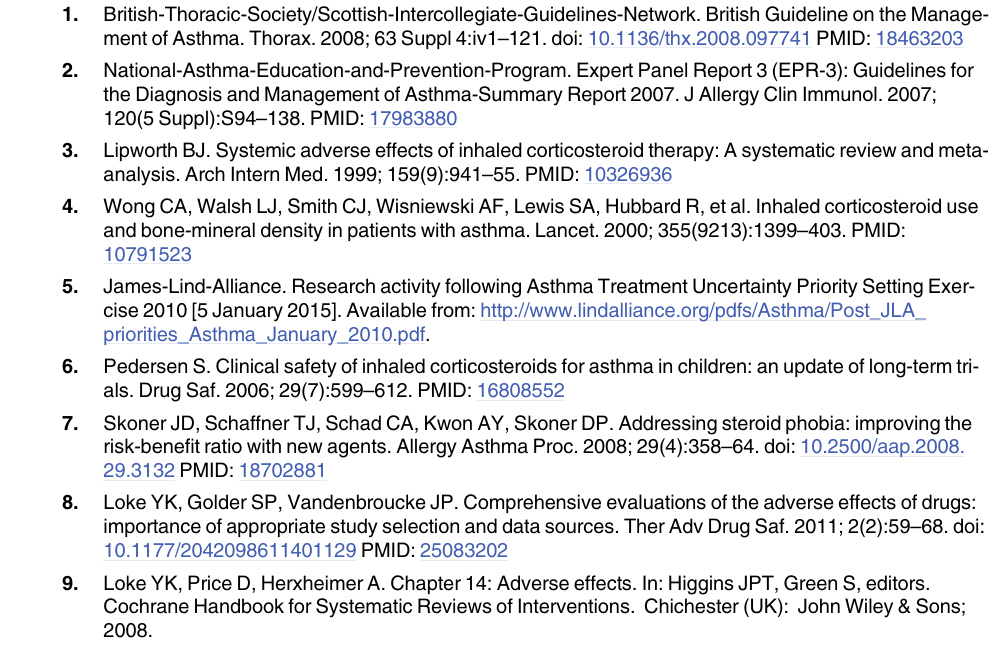
S1 Table. Characteristics of randomized controlled trials included in the analysis of growth. S2 Table. Characteristics of observational studies. S3 Table. Risk of bias assessment and growth outcomes in RCTs of inhaled corticosteroids. S4 Table. Study Validity and Growth Outcomes in Observational